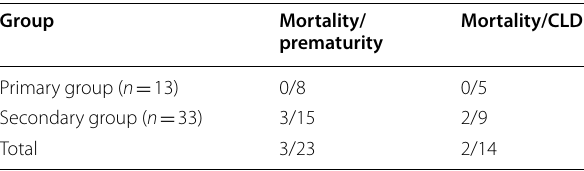
A total of 9 patients had combined prematurity and CLD one of them died